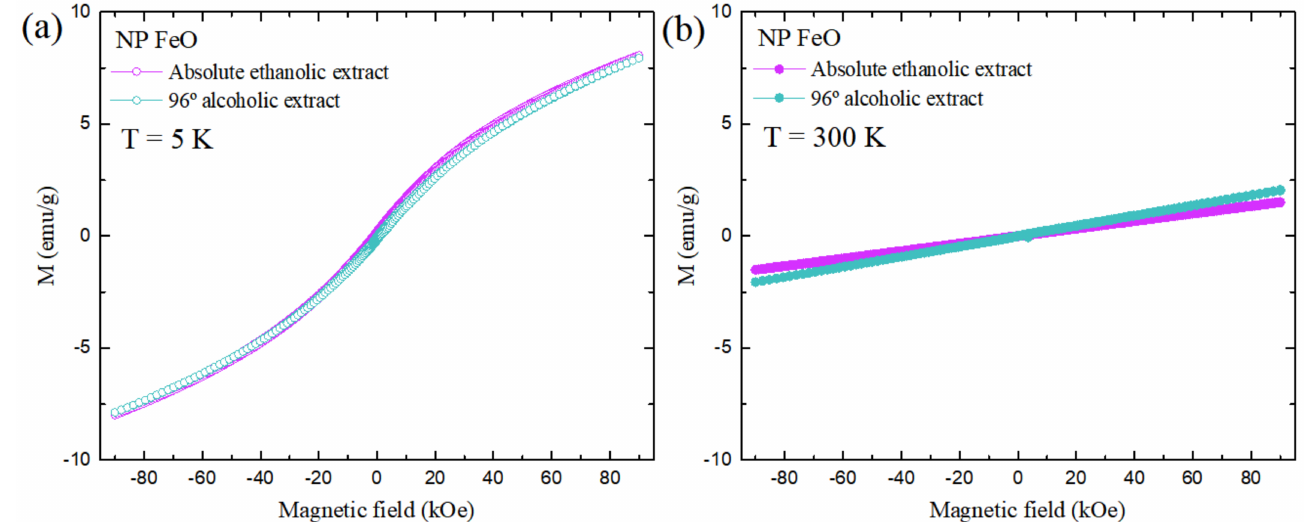
Figure 8. Saturation magnetization values as a function of field hysteresis applied to FeO NPs synthesized by the green path at ( a ) 5 K and ( b ) 300 K.